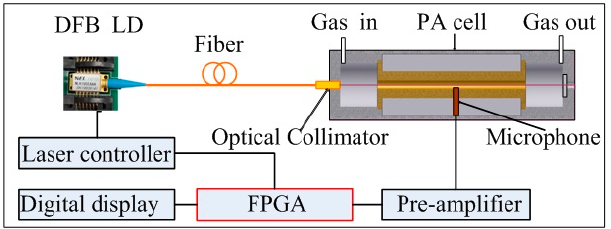
Figure 1. Schematic configuration of the PA methane sensor.